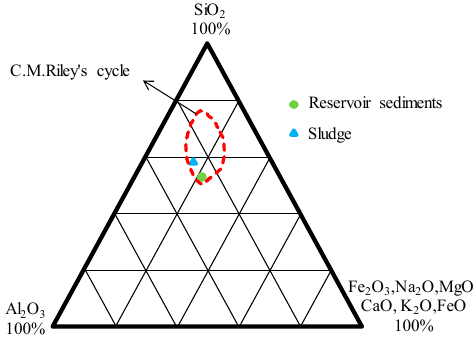
Figure 2. Ternary diagram of sludge and reservoir sediments.